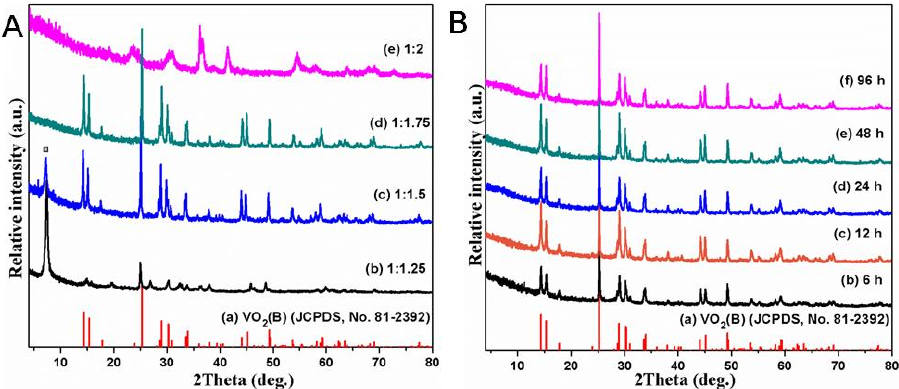
Figure 1. XRD patterns of the samples with various conditions: ( A ) various ratio of V:C (180 °C, 48 h); ( B ) reaction time (V:C = 1:1.75, 180 °C).